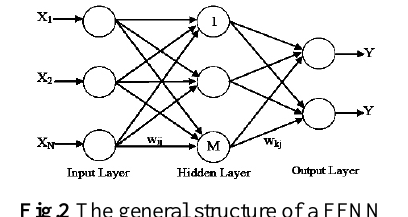
Fig.2 The general structure of a